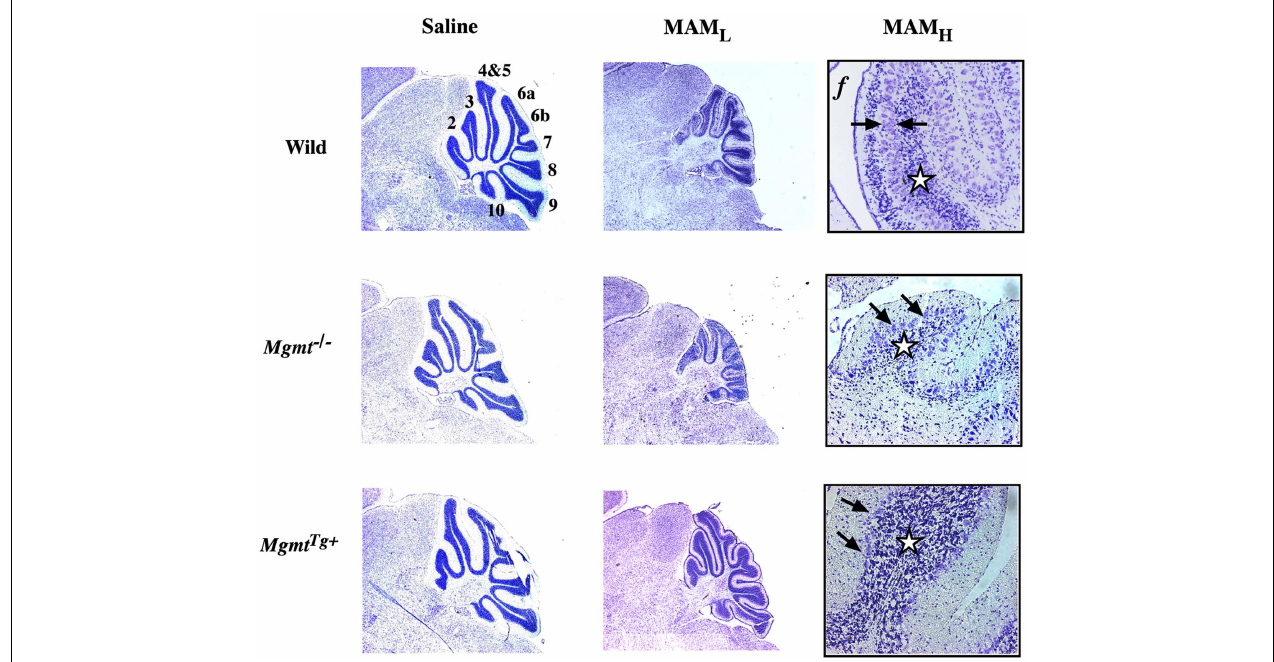
cerebellum from wild-type or DNA repair mutant mice treated with MAM ( right panels ). MAM L , low magnification (3.85 × ), MAM H , high magnification (77 × ), f , folia. Arrows indicate disorganization of Purkinje cell layer and stars denote reduced density of neurons in granule cell layer. Mgmt : gene coding for O 6 -mG-methyltransferase (MGMT), which is knocked out in Mgmt − / − and overexpressed in Mgmt Tg + mice (modified from Kisby et al.,